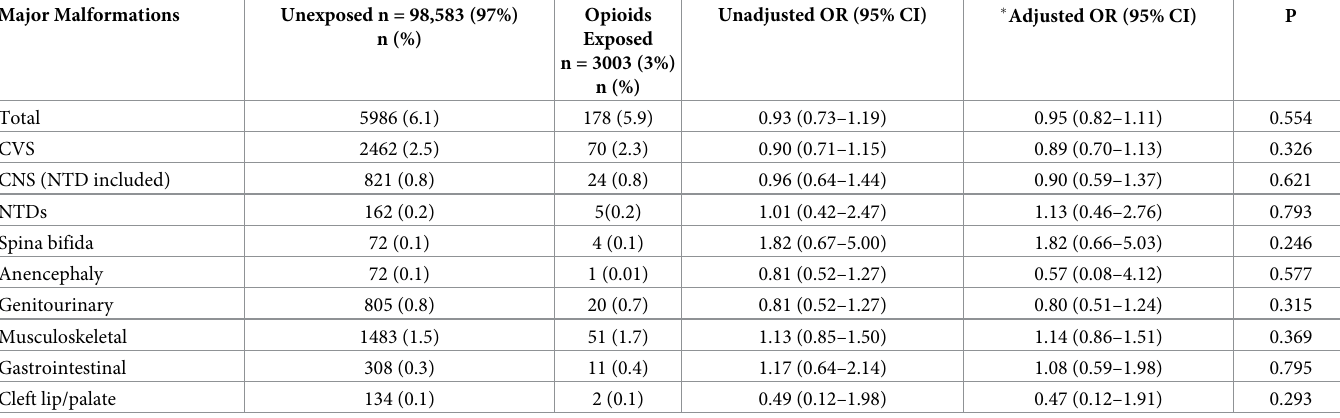
Table 2. Unadjusted and adjusted risk (odds ratios (OR) and 95% confidence intervals (95% CI)) for congenital malformations after intrauterine exposure to opi- oids during the first trimester of pregnancy compared to unexposed. Major